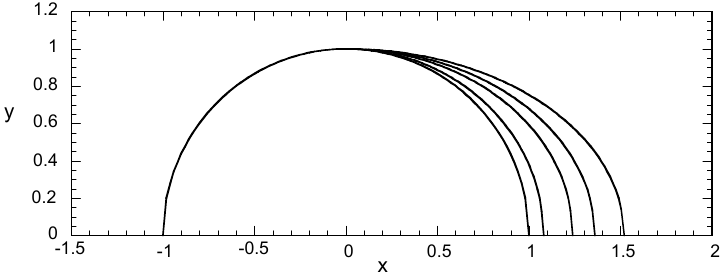
Figure 6. Evolution of contact line shape corresponding to the contact angle distribution of Figure 5.